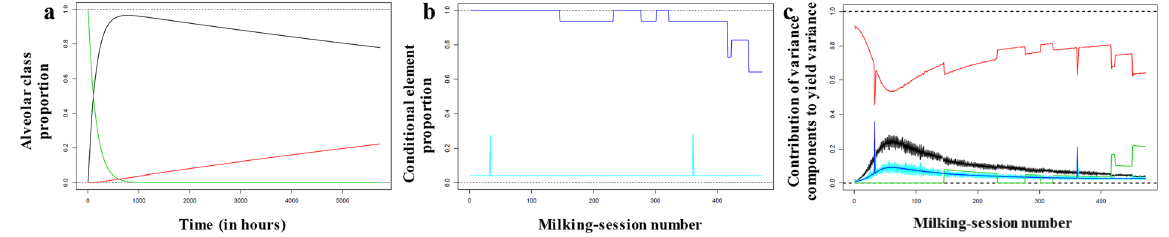
Figure 4. Estimates of unobserved variables. ( a) Alveolar class proportions over time: non-activated alveoli (green line), activated alveoli (black line), and inactivated alveoli (red line). ( b ) Conditional elements operating during milking sessions: β (dark blue line) and π (light blue line). ( c ) Relative contribution of variance components to milking-session variance in yield (% provided is the estimate for whole lactation period): alveolar class proportions (78.4%; red line); measurement error (9.4%; black line); β (4.3%; green line); π (4.0%; blue line); and milk carryover (3.9%; cyan